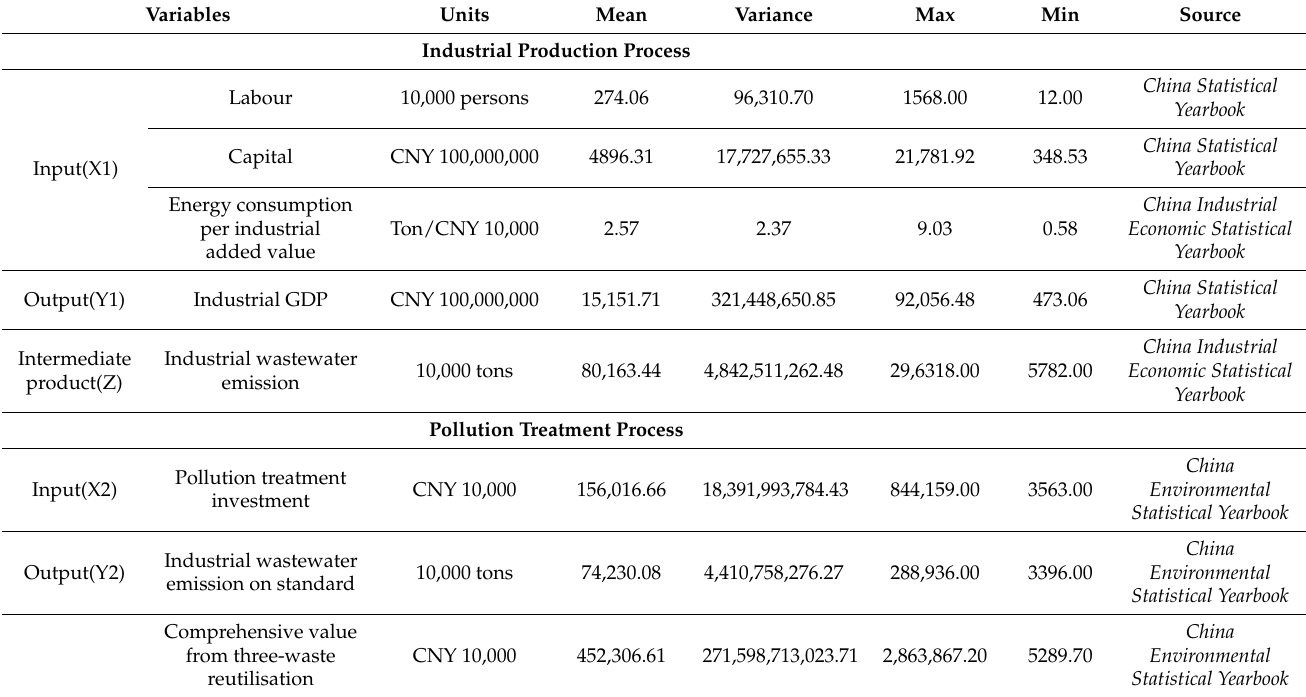
Table A1. Descriptive statistics of the raw data.